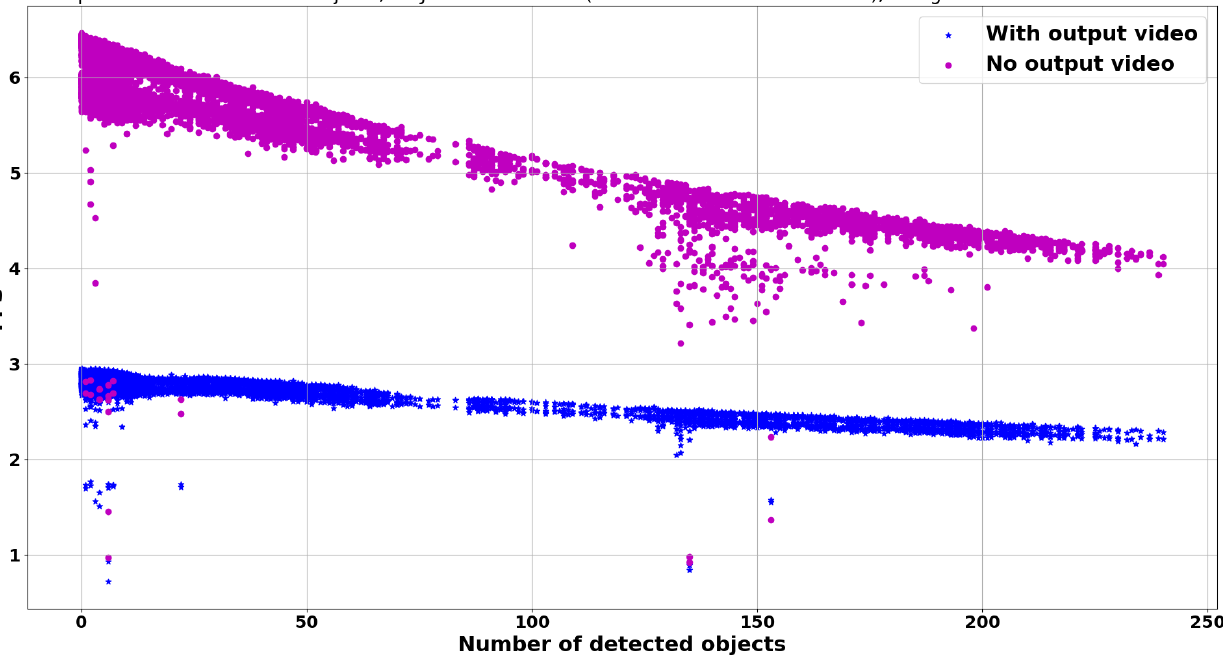
Figure 12. Inference speed (in FPS) per number of detected objects, on Jetson Xavier NX, with an input video resolution of 1920 × 1080, using the TRT version of the YOLOv7 object detection model, with no tracker, when including or excluding the saving of the video